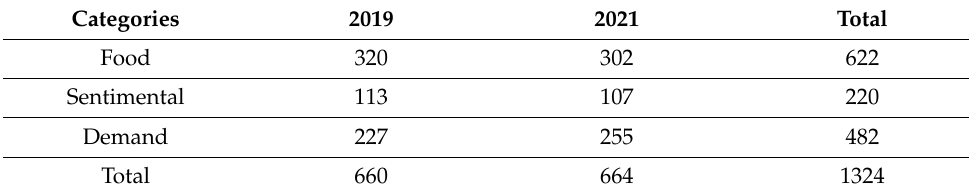
Table 2. Narrative coding